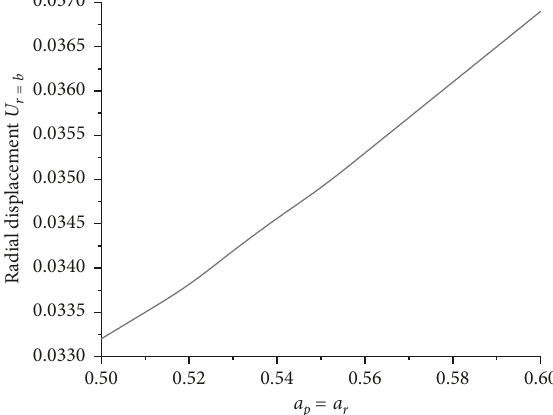
Figure 27: Variation of radial displacements on the opening surface with the change of parameter a considering seepage